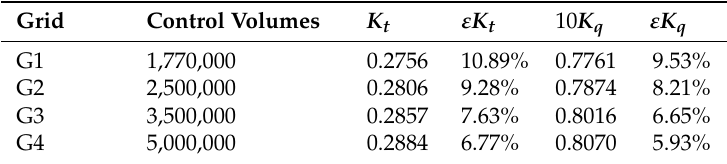
Table 3. Results from the grid